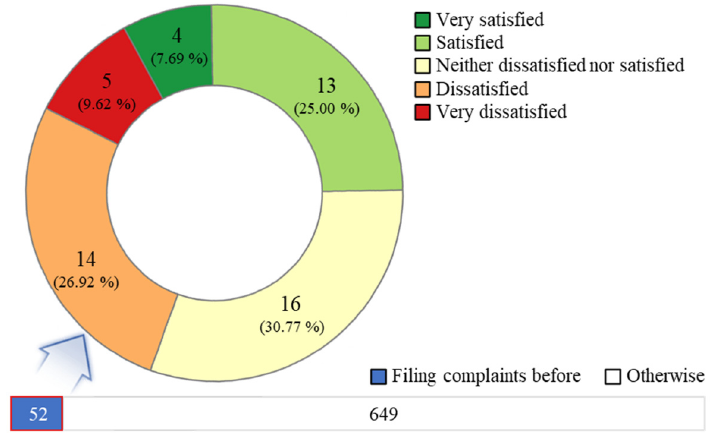
Figure 3. Detailed responses (total number) on the satisfaction level with respect to complaint handling.